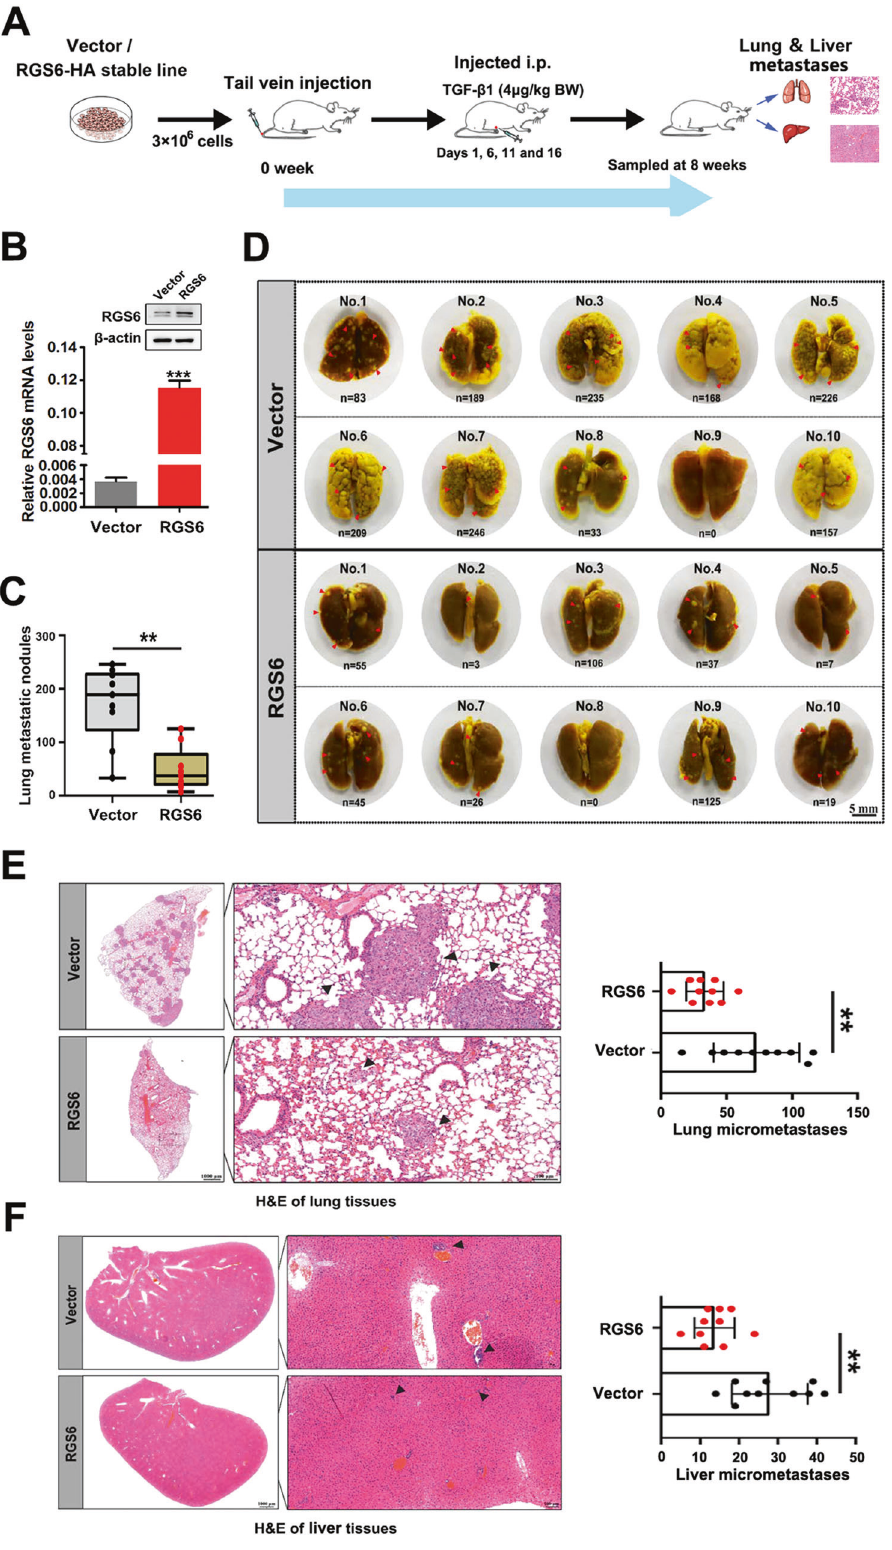
A549 cells were signi fi cantly lower compared to mice injected with control A549 cells (Fig. 3C). The lung and liver tissues were then subjected to histological analysis for detection of micro- metastases in these tissues. Sample pictures of lung tissue sections